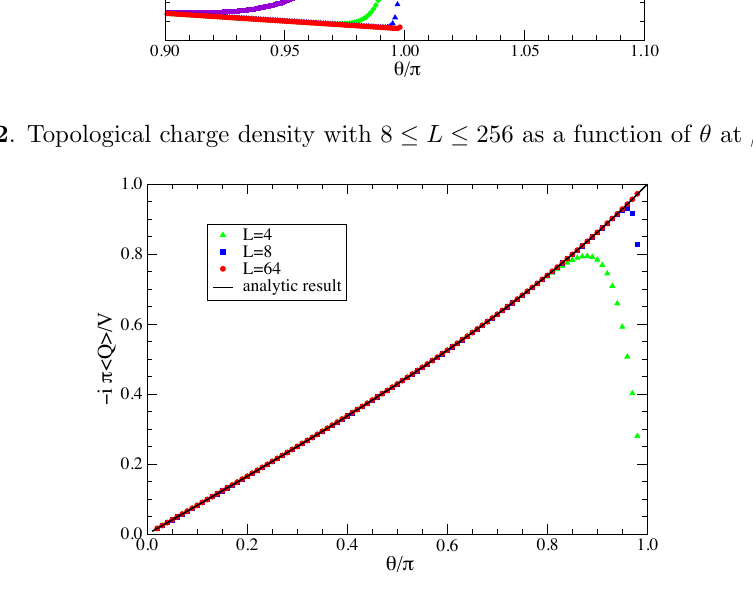
Figure 3 . Topological charge density with 4 (cid:20) L (cid:20) 64 as a function of (cid:18) at (cid:12) = 0 : 0. Solid curve denotes the analytic result of eq. (3.5) obtained in the in(cid:12)nite volume